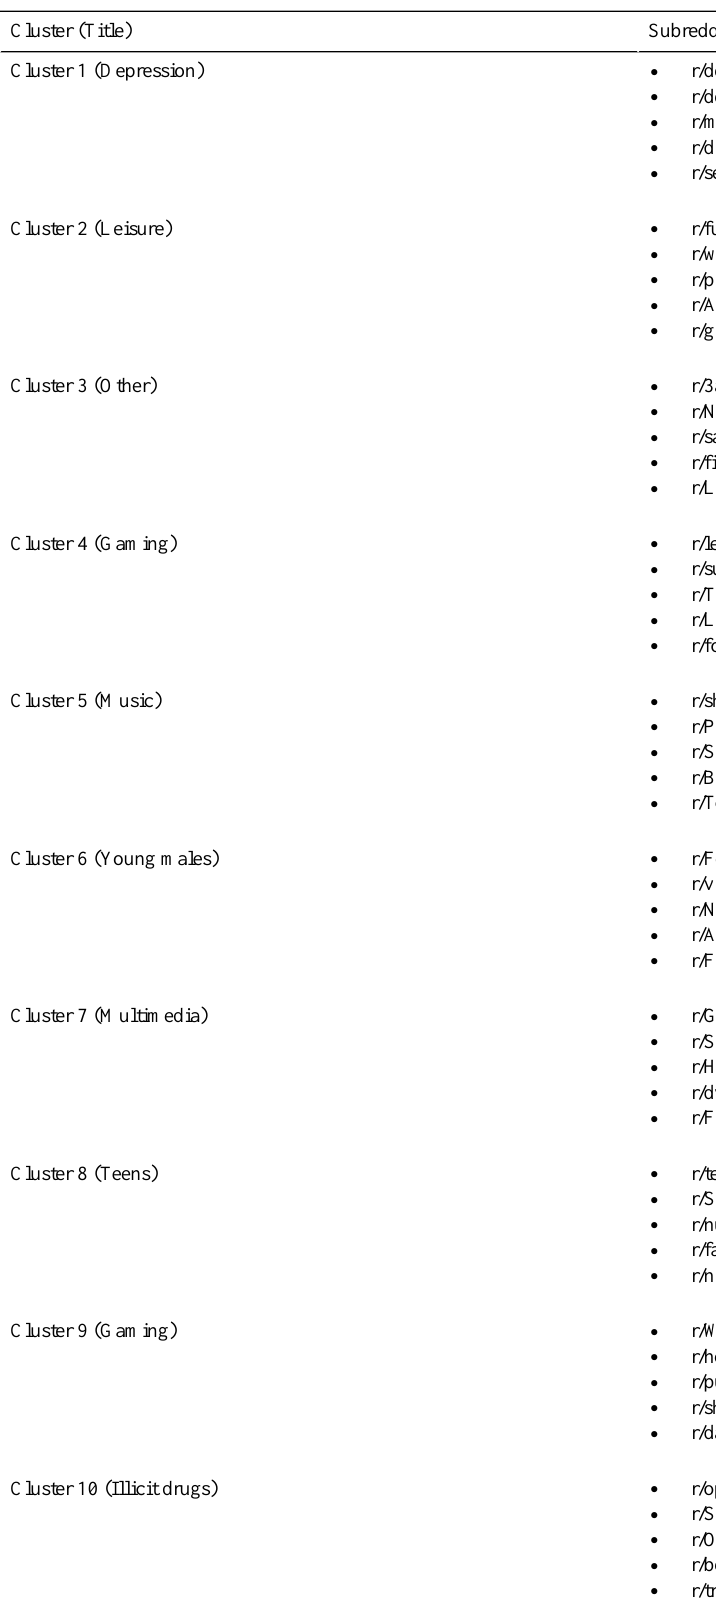
Table 3. Most important forums in each cluster, according to the strength of the latent factors identified by nonnegative matrix factorization. Cluster titles are suggested by the